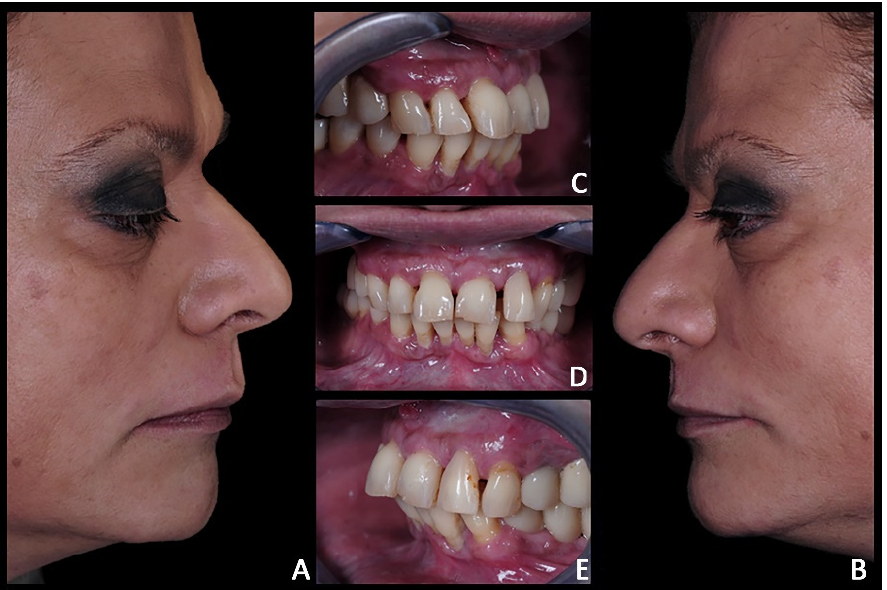
Figure 15. Case 3. Pre-treatment patient characteristics: extra-oral and intra-oral photographic records. ( A ) Extra-oral right profile view; ( B ) extra-oral left profile view; ( C ) intra-oral lateral right view; ( D ) intra-oral frontal view; ( E ) intra-oral lateral left view